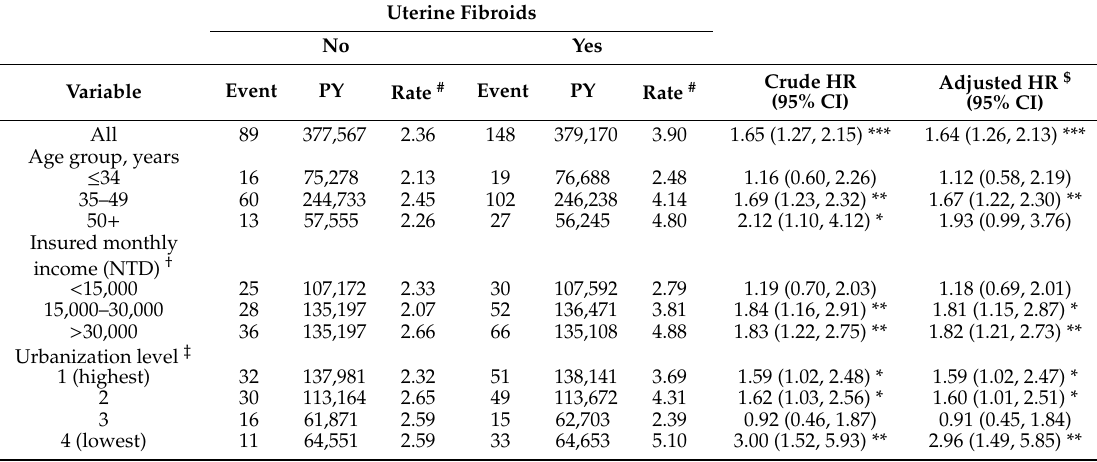
Table 2. Incidences and hazard ratios of thyroid cancer between women with and without uterine fibroids, stratified by demographics, comorbidities, and follow-up